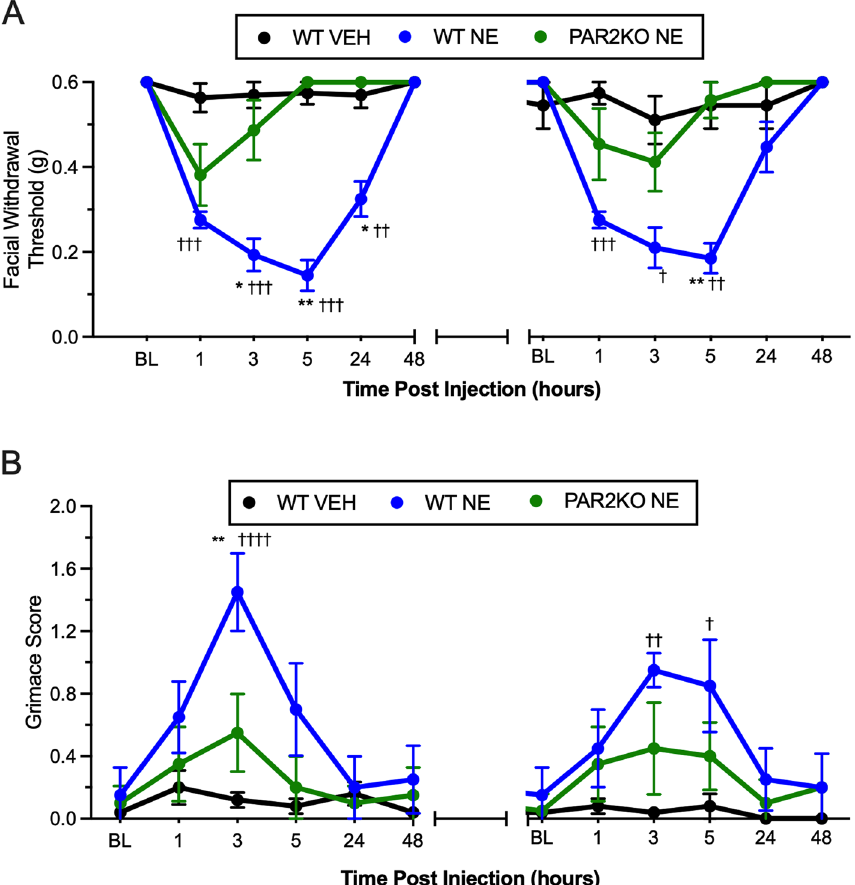
Fig. 4 Dural neutrophil elastase (NE) causes hyperalgesic priming to GTN. A Facial withdrawal thresholds in PAR2KO mice following treatment of NE ( n 4), WT controls following treatment of NE ( n 4), and WT controls following administration of vehicle ( n 5) and subthreshold GTN. Note = = = that there are 12 days between the last time point of 48 h on the left and the baseline for GTN administration, indicated by the broken x-axis (see Fig. 1C). Application of NE significantly decreased withdrawal thresholds in WT mice and enhanced hyperalgesic priming to GTN compared to WT mice treated with vehicle (†) and PAR2KO administered NE (*). B Grimace scores of PAR2KO mice and their WT controls. NE significantly increased grimacing in WT mice compared to WT mice treated with NE. *, † p < 0.05, **, †† p < 0.01, ††† p < 0.001, †††† p < 0.0001. Data are represented